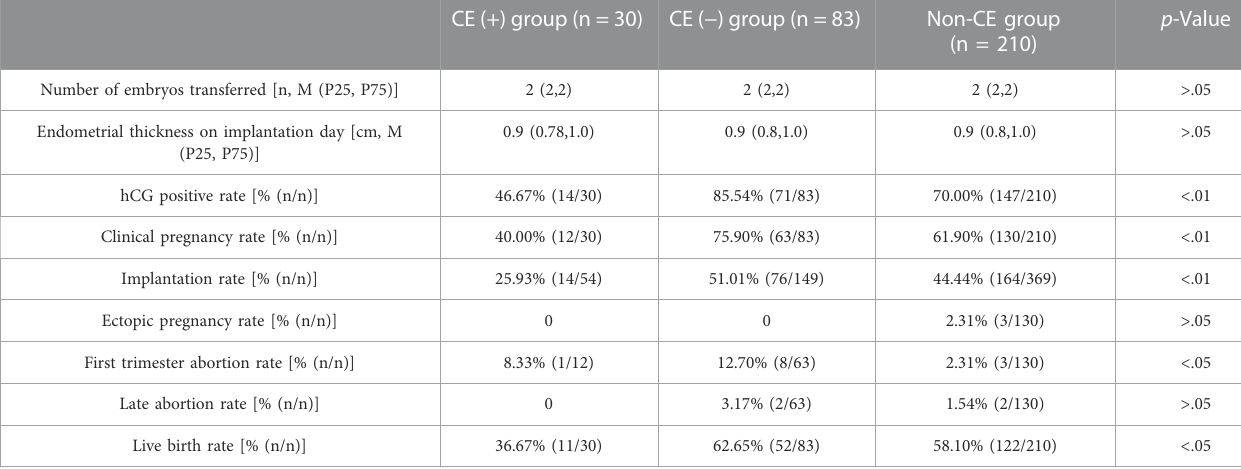
TABLE 2 The outcomes of three groups with FET.